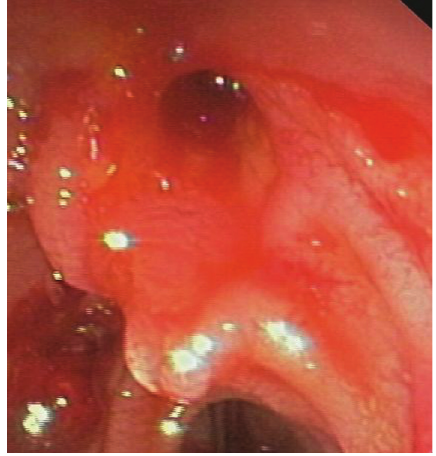
Figure 10: No signs of bleeding after stent